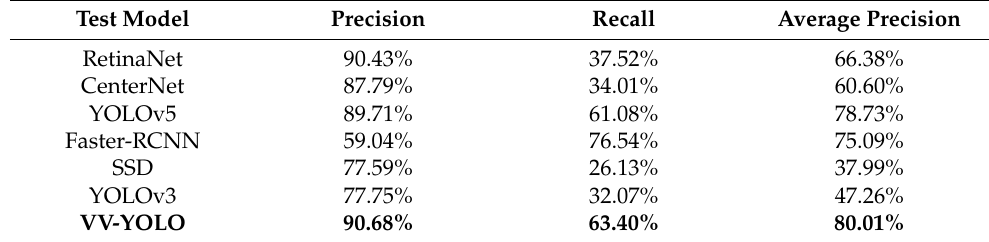
Table 4. Comparative test results of the VV-YOLO model and mainstream object detection